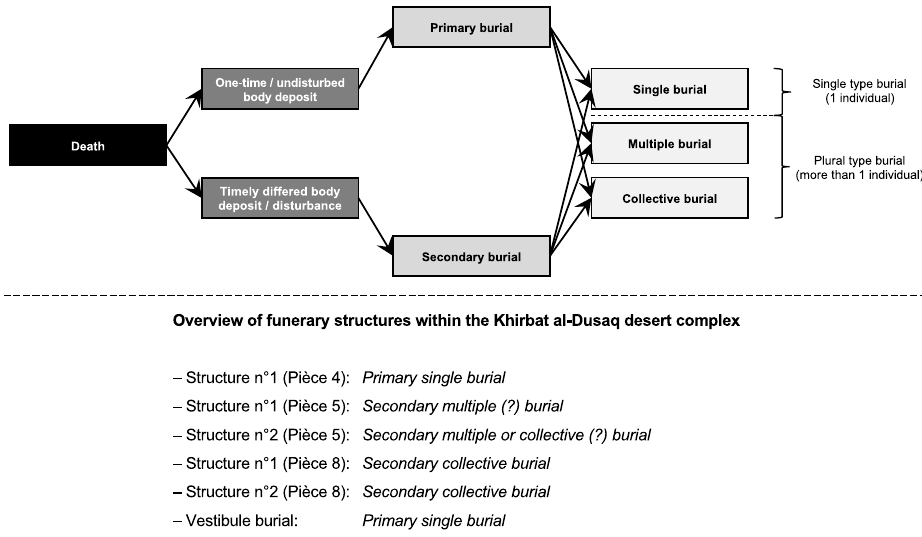
Figure 3: Schematic graphic summing - up of di ff erent possible types of funerary treatment and burial modalities. Compiled by Hofstetter ( 2022 )